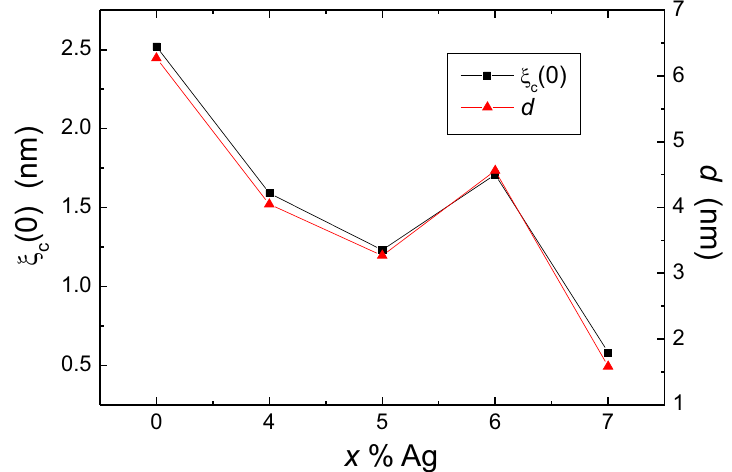
Figure 9. Superconducting coherence length, ξ c ( 0 ) , and thickness of the 2D fluctuation layer, d , as a function of the Ag